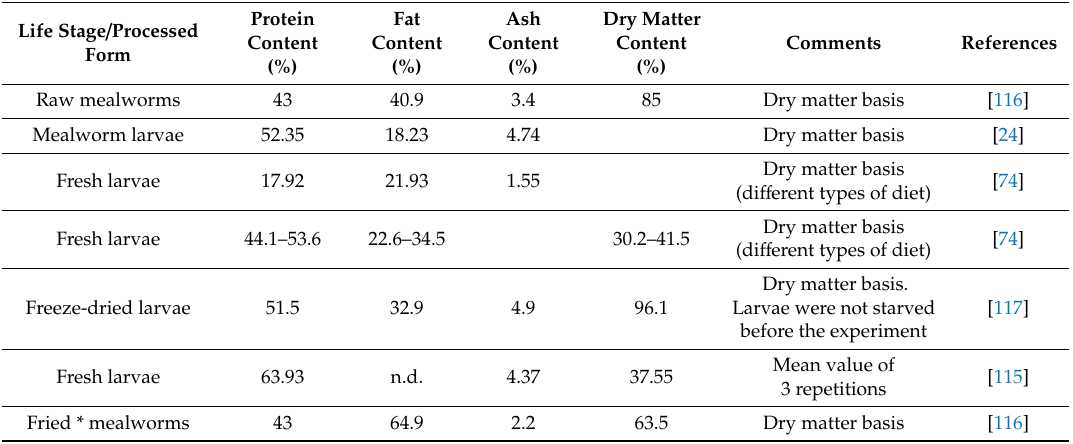
Table 3. The nutritional composition of mealworms in the reviewed